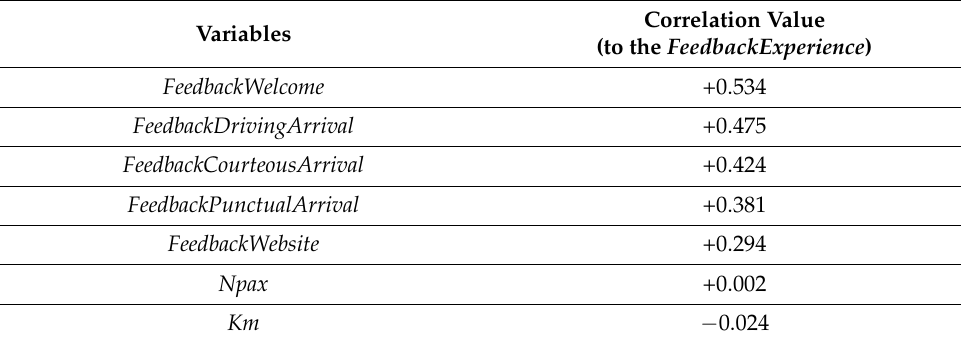
Table 5. Pearson’s correlation values between the FeedbackWelcome, FeedbackDrivingArrival, FeedbackCourteousArrival, FeedbackPunctualArrival, FeedbackWebsite, Npax, Km variables, and